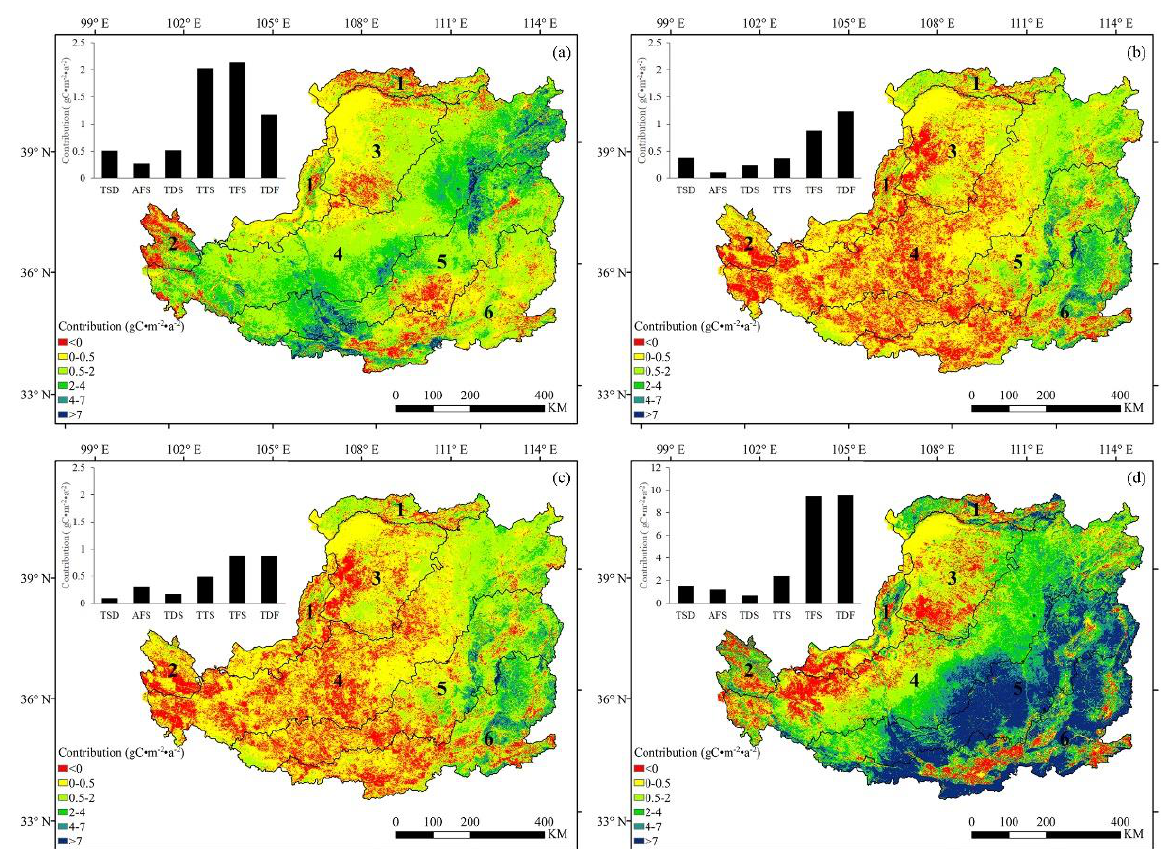
Figure 5. Contribution of each driving factor to interannual variations in NPP: ( a ) precipitation; ( b ) temperature; ( c ) radiation; ( d ) human land use. Red pixels represented weakly negative contributions to NPP increases. Yellow pixels represented faint positive contributions to NPP increases. Green pixels represented obvious positive contributions to NPP increases. The numbers on the pixels represent six sub-regions on the LP: (1) Temperate steppe desert (TSD), (2) alpine forest–steppe (AFS), (3) temperate desert–steppe (TDS), (4) temperate typical steppe (TTS), (5) temperate forest–steppe (TFS), (6) temperate deciduous forest (TDF).